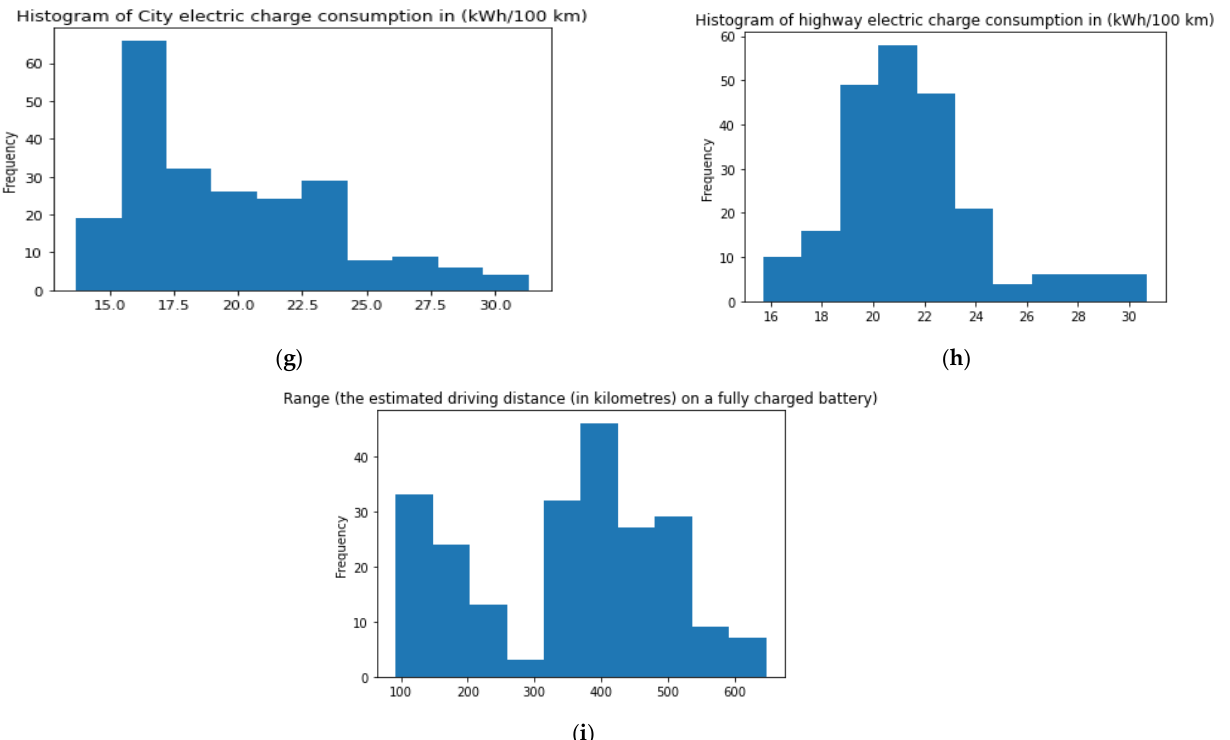
Figure 3. Dataset visualization. ( a ) Motor Power; ( b ) Combined electric charge consumption; ( c ) City litre consumption equivalent; ( d ) Highway litre consumption equivalent; ( e ) Recharge Time; ( f ) Combined (highway and city) consumption equivalent; ( g ) City electric charge consumption; ( h ) highway electric charge consumption; ( i ) Range.